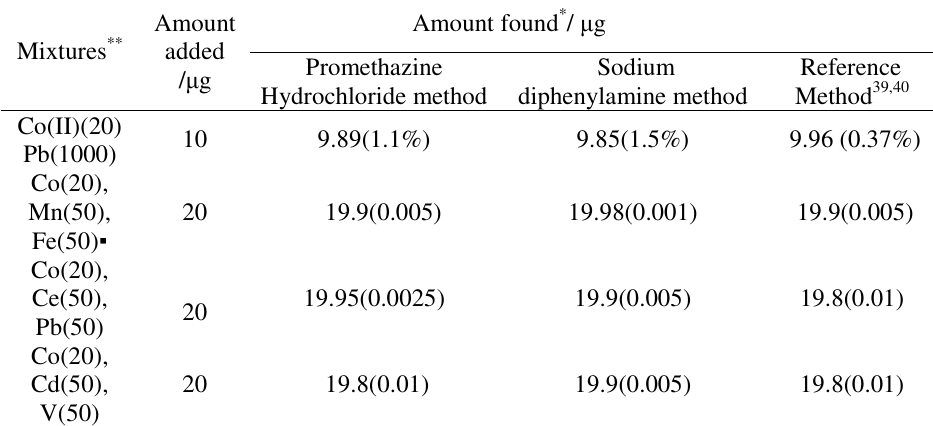
Table 1. Determination of Cobaltl(II) in Synthetic